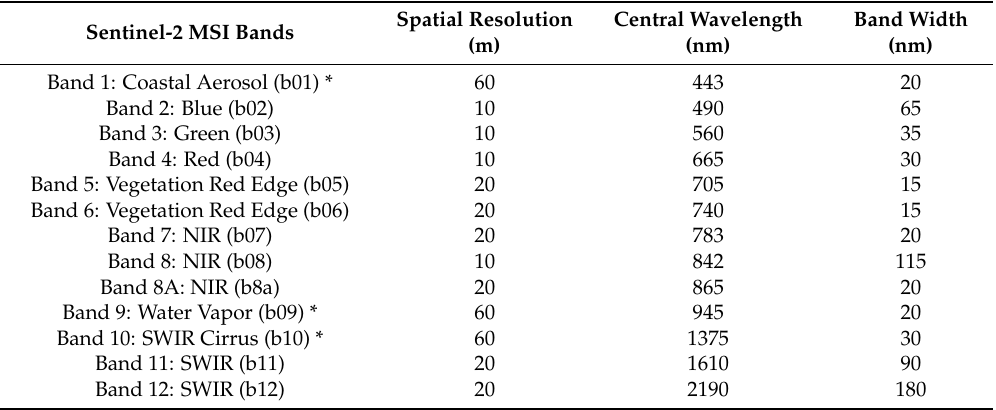
Table 2. Spectral and spatial resolution of the Sentinel 2A MSI bands (* denotes bands not considered in study.). Sentinel-2 MSI Bands